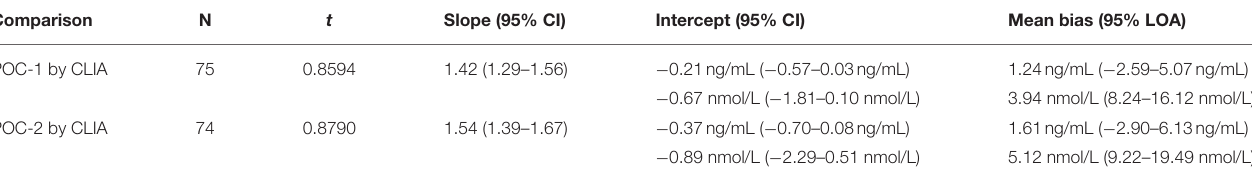
TABLE 2 | Passing-Bablok regression and Bland-Altman analytics of canine serum progesterone concentrations measured by two point-of-care analyzers (POC-1 and POC-2) and a reference chemiluminescent immunoassay (CLIA). Comparison